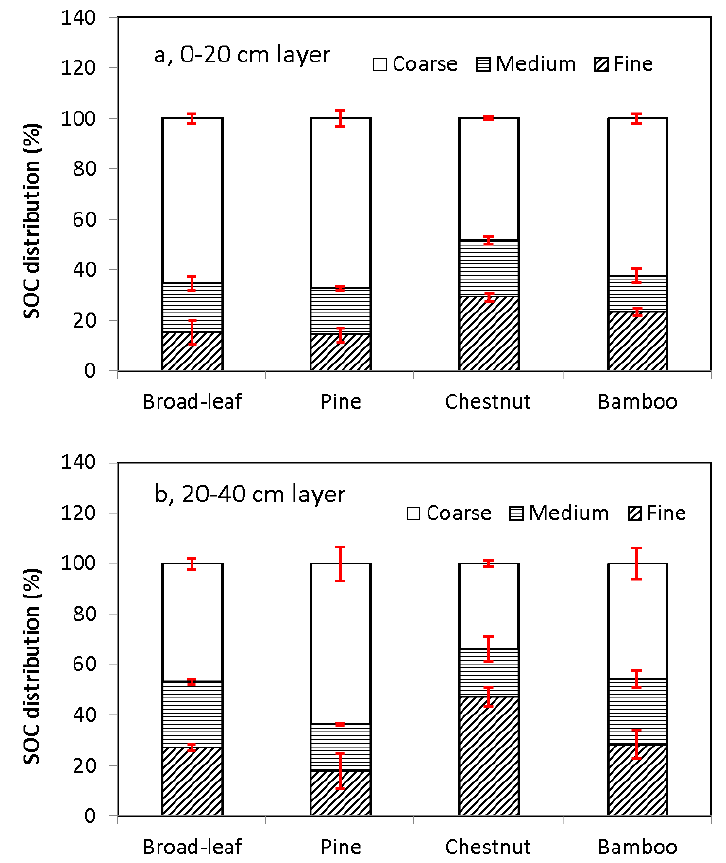
Figure 2. Mean SOC distribution (%) in particle size fractions in the ( a ) 0–20-cm soil layer and ( b ) 20–40-cm soil layer under four types of forest vegetation-land use. The